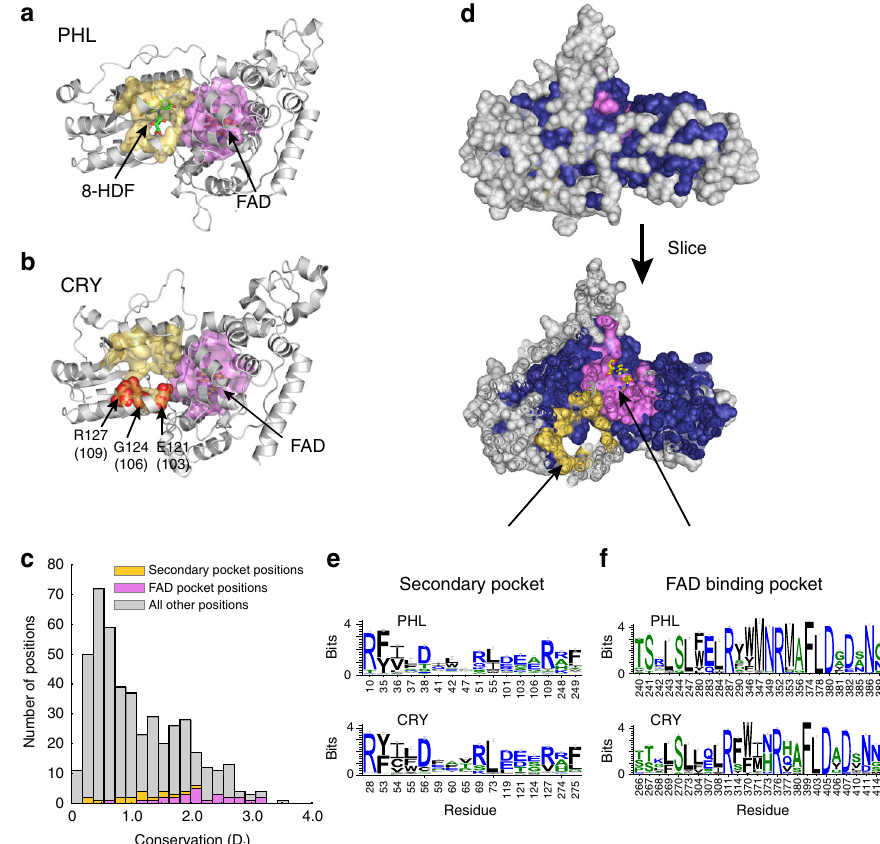
Fig. 1 Identi fi cation of an allosteric secondary pocket in the CRYs by comparison to the PHLs. a The PHL domain is shown in gray cartoon (PDB: 1TEZ). The secondary pocket (yellow surface) and primary FAD-binding pocket (pink surface) were de fi ned as all residues with at least one atom within 4 Å of 8- hydroxy-7,8-didemethyl-5-deazaribo fl avin (8-HDF) (green sticks) or FAD (yellow sticks) respectively. b The FAD-binding and secondary pockets mapped to the CRY2 structure (PDB: 4I6G). Three positions within the secondary pocket were previously identi fi ed in a functional screen (highlighted as red spheres). c Distribution of conservation values for all positions in the CRY/photolyase family (CPF) alignment. Conservation is computed as the Kullback – Leibler relative entropy ( Di ), which measures the divergence of amino acid frequencies at a particular position from the distribution expected by random chance. Values near zero indicate that the observed frequencies at a site are close to random expectation, while values above three re fl ect positions approaching near-total conservation (84% identity or more). The majority of positions are weakly conserved; the secondary pocket positions (yellow) are moderately conserved, and the FAD-binding pocket positions (pink) are more conserved. d Mapping of the sector (dark blue spheres) to the respectively. e – f Sequence logo plots describing the sequence variation in the FAD-binding pocket and secondary pocket. Residue numbers correspond